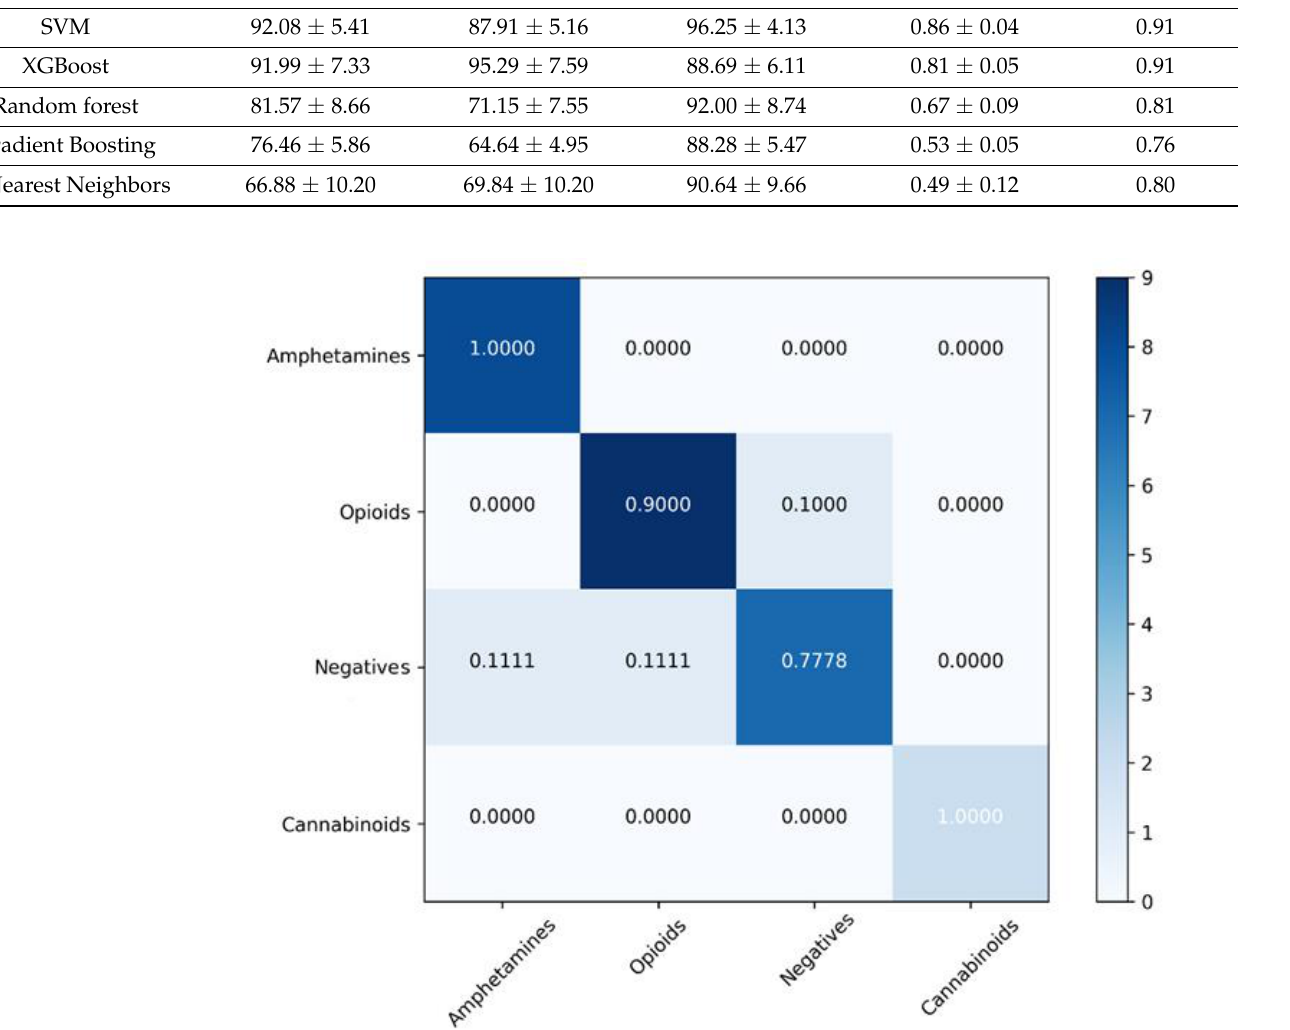
Figure 6. Confusion matrix for the XGB model.